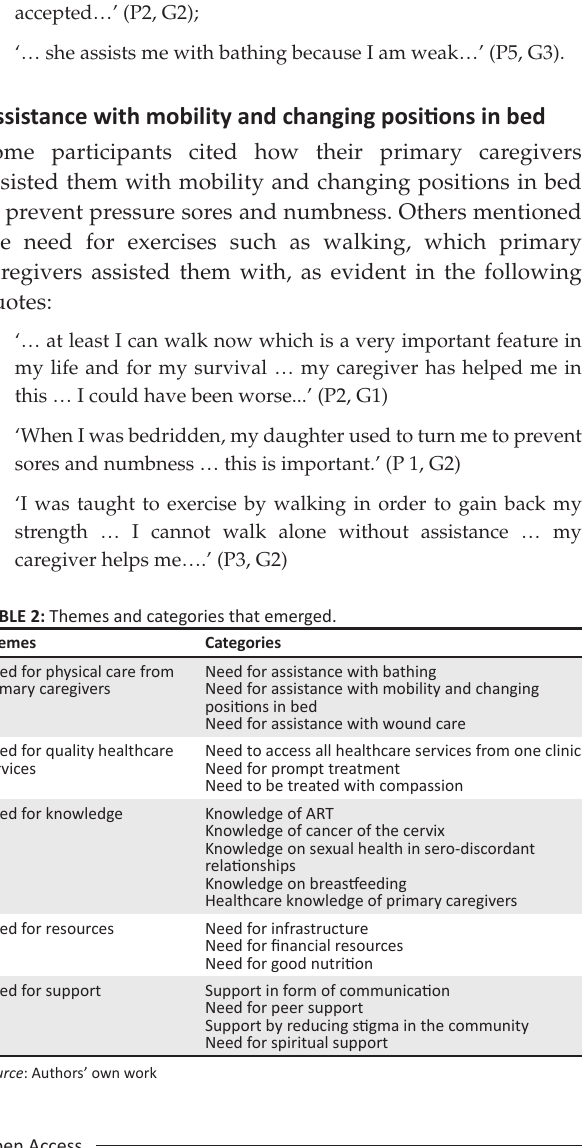
Theme one: Need for physical care from primary caregivers